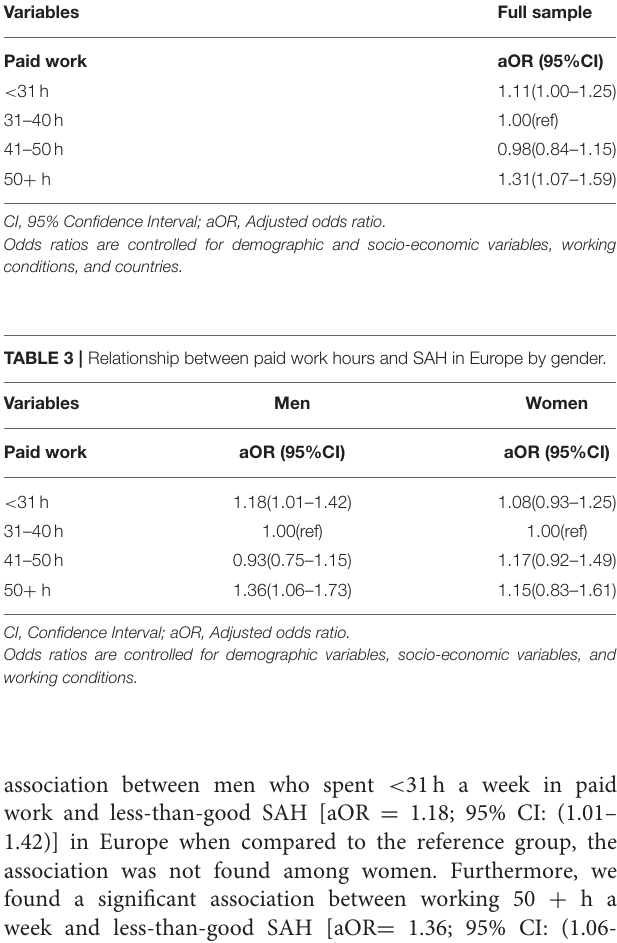
TABLE 2 | Association between paid work hours and SAH among workers from the European Working Condition Survey 2015. Variables